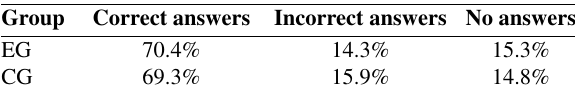
Table 6. Formation of propan-2-ol, percentages of correct and in- correct answers.